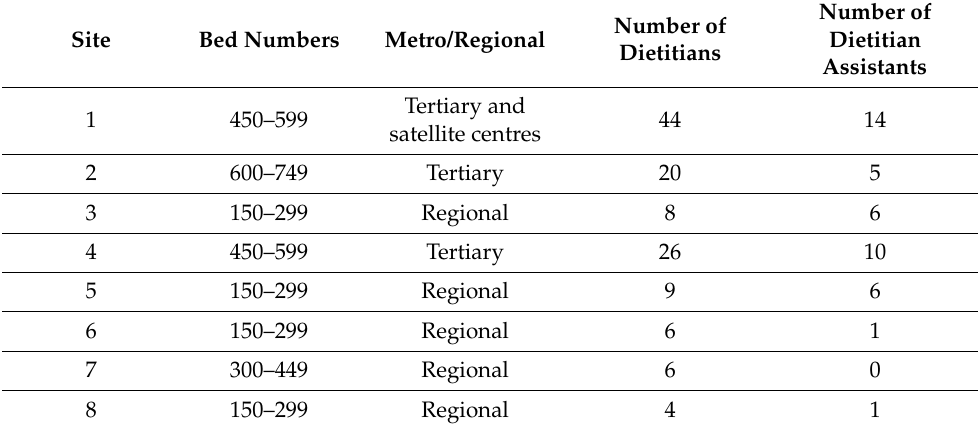
Table 1. Demographics of participating sites.